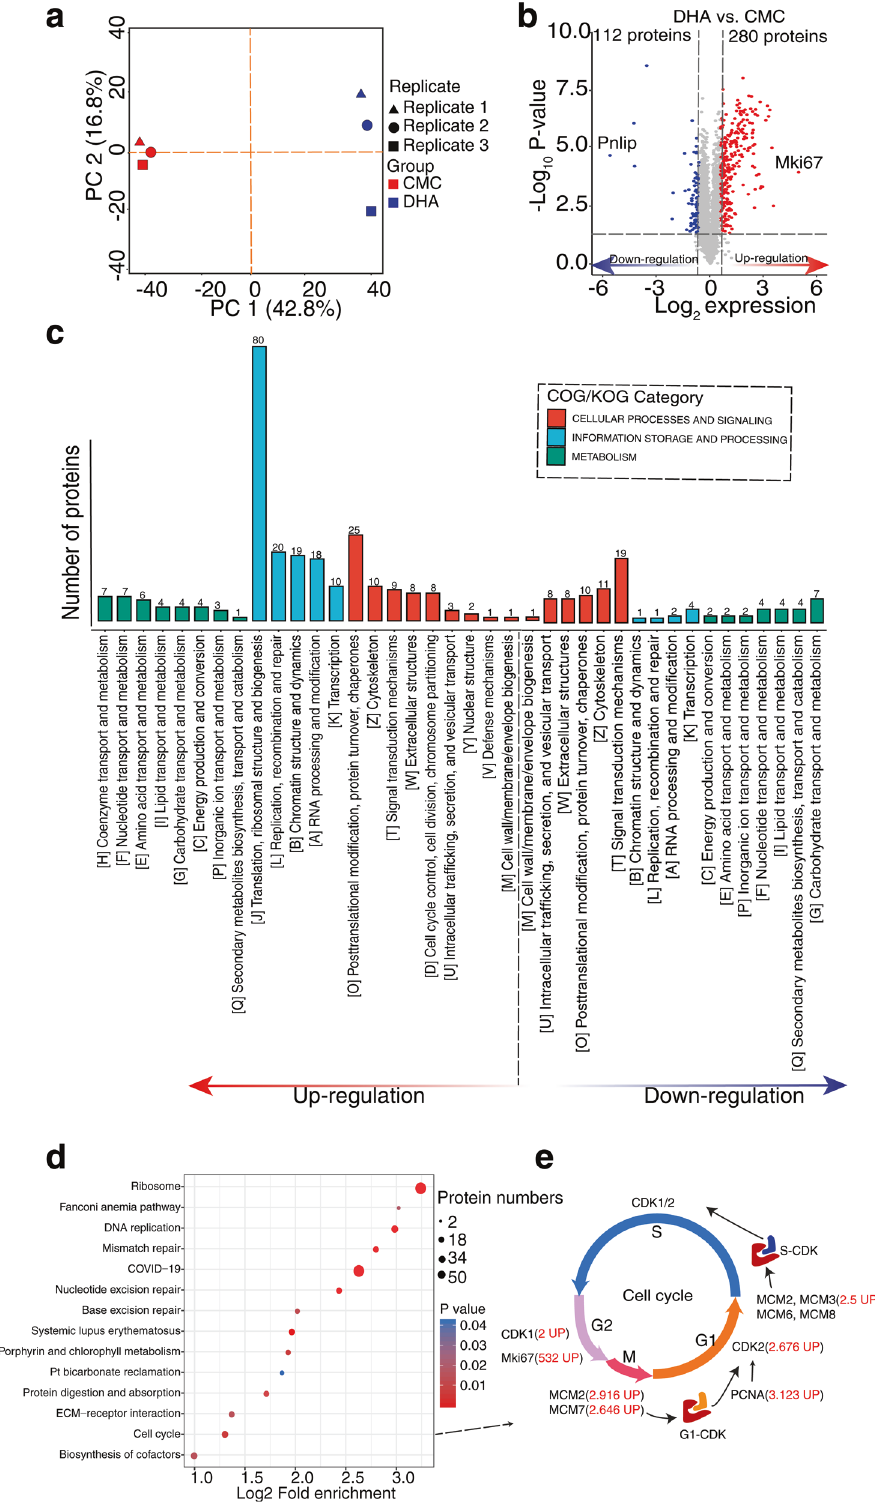
Fig. 2 Quantitative proteomics revealed cell cycle progression through activation of cell cycle related proteins promoted by DHA. a The principal component analysis (PCA) at the proteomics level for a total of six spleen samples of the DHA- and CMC- gavage mice. b Differentially expressed proteins were displayed by volcano plots. The vertical lines correspond to 1.5-fold up and down, respectively, and the horizontal line represents the P -value cut-off of 0.05. Upregulation of protein expression in DHA group is shown in red, while downregulation is shown in blue. c KOG classi fi cations of differentially expressed proteins (DEPs). The ordinate denotes the number of proteins in each KOG category. d A bubble chart showing the KEGG pathways. The bubble size represents the number of DEPs, and the bubble color represents the p value. e The pathway map showed the different key proteins involved in the cell cycle signaling pathways. DHA = dihydroartemisinin group, CMC = CMC (carboxymethyl cellulose) solvent solution control group Signal Transduction and Targeted Therapy (2022)